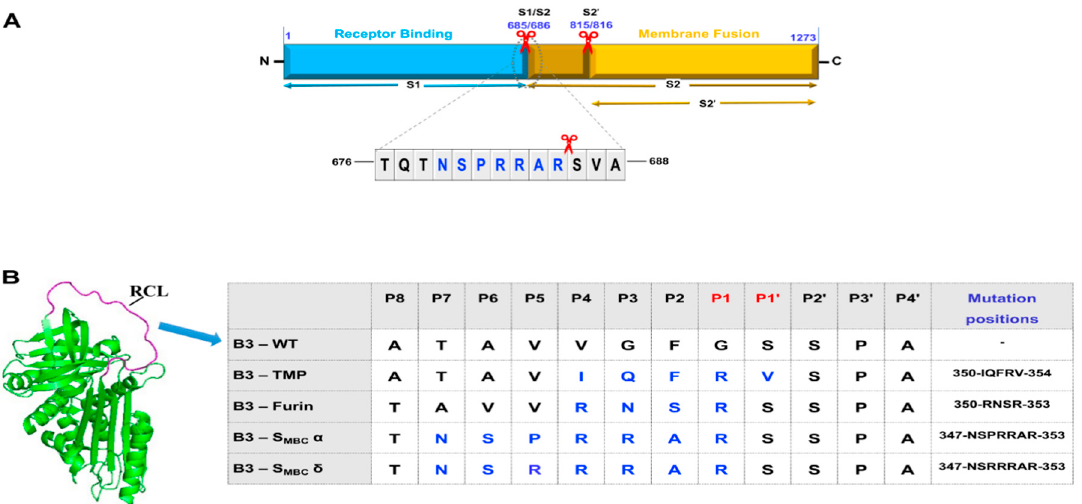
Figure 1. SerpinB3 variants designed with modified RCL sequences to inhibit TMPRSS2 and furin. ( A ) Schematic representation of coronavirus spike protein with cleavage sites. ( B ) The structure of native serpin archetype with RCL highlighted in magenta, containing a protease cleavage site (P1-P1’). Amino acid substitutions are highlighted in blue in the table, with the SerpinB3-WT sequence shown in black. The image was made in PyMol using the PDB file code 1QLP.